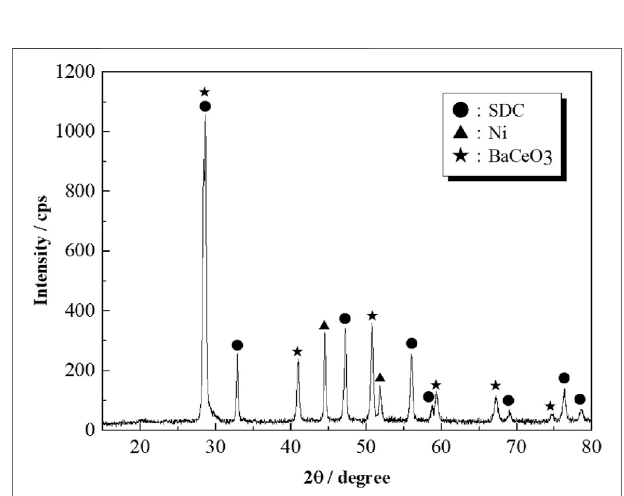
FIGURE 12 | XRD pattern of the 20wt% BaO-added Ni/SDC powder fi red at 700 ° C and reduced in H 2 at 900 ° C.